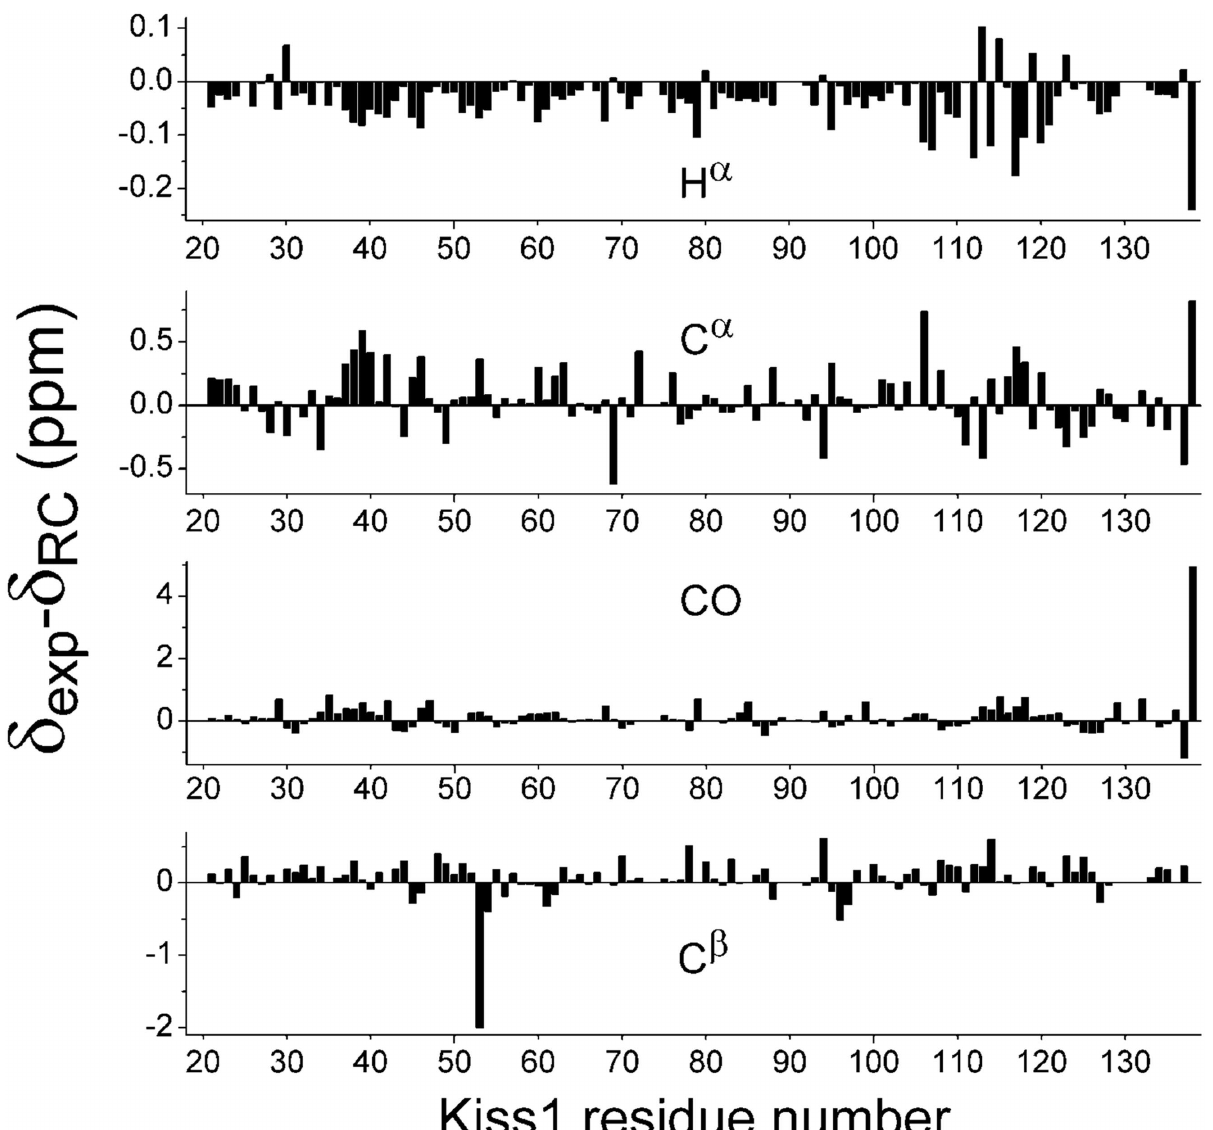
Fig 4. KISS1 residue plots of secondary chemical shifts for backbone and C β nuclei referencedagainst their random coil values [33]. The large deviationof C β for C53 is not due to cisteine oxidation. The measuredvalue of 27.89 ppm indicates a reducedside chain